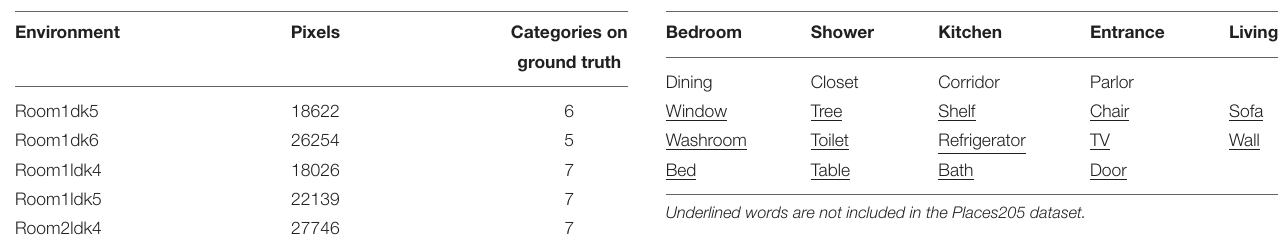
TABLE 2 | Information about each room in the simulation. TABLE 3 | Vocabulary list used in the simulation environment.